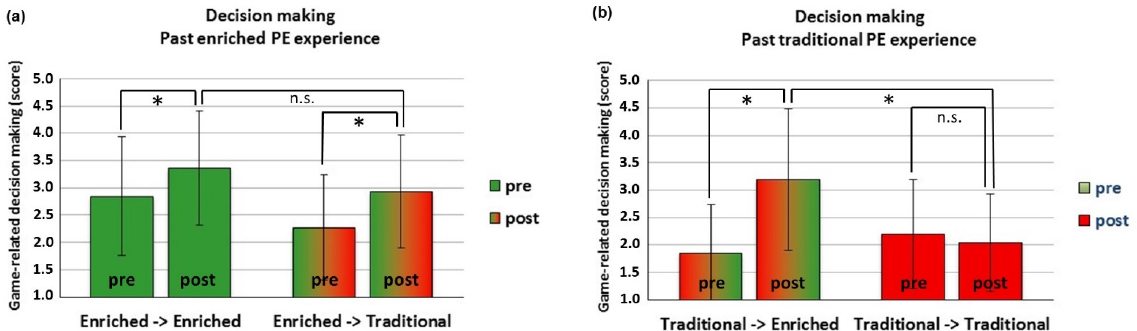
Figure 4. ( a , b ). Average value of game-related decision making and support scored with the Game Performance Assessment Instrument for Invasion Games before (pre) and after (post) the actual enriched PE or traditional PE intervention. Panel ( a ): past enriched PE experience; panel ( b ): past traditional PE. * p < 0.016 (adjusted for tree comparisons); n.s.: non-significant.